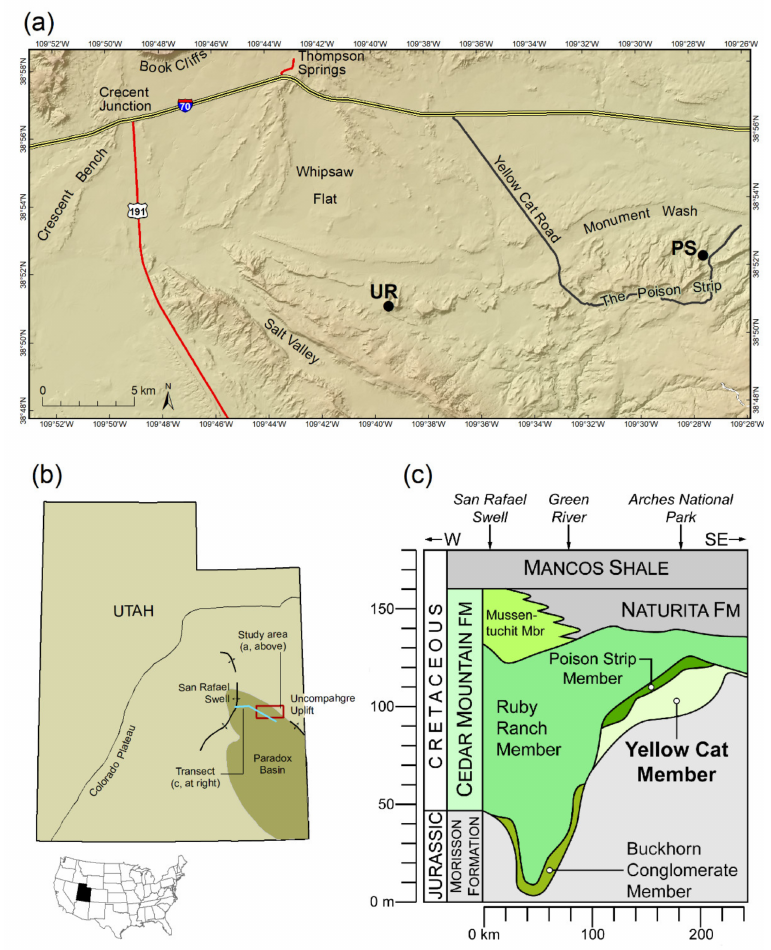
Figure 1. Geographic and stratigraphic setting of study site. ( a ) Location of Utahraptor Ridge site (UR) in Grand County, Utah, USA. The Yellow Cat Member of the Cedar Mountain Formation was previously described by Joeckel et al. [3,4] at Poison Strip (PS). ( b ) Location of study area identified in ( a ) within Utah and relative to major structural and physiographic features. ( c ) Simplified cross- section of Cedar Mountain Formation in southeastern